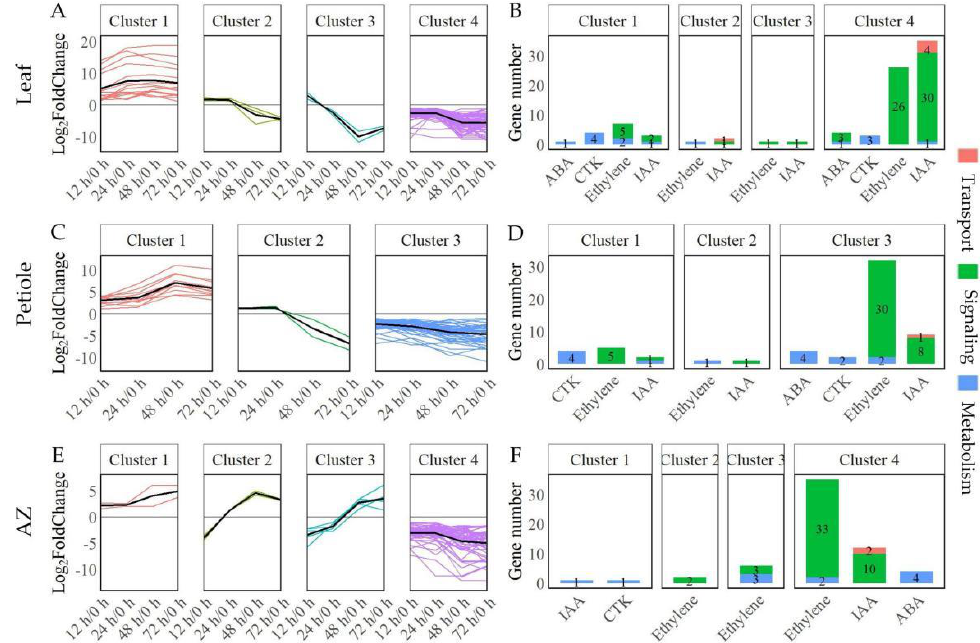
Figure 6. The dynamic expression and gene numbers of DEGs related to phytohormone in leaf, petiole, and AZ upon TDZ treatment. K-means clustering and gene numbers at four time points upon TDZ treatment in leaf ( A , B ), petiole ( C , D ), and AZ ( E , F ), respectively. DEGs were determined between 12 h and 0 h, 24 h and 0 h, 48 h and 0 h, 72 h and 0 h, respectively. The DEGs were controlled by FDR<5% and |log2Fc|≥1 at all four time points.